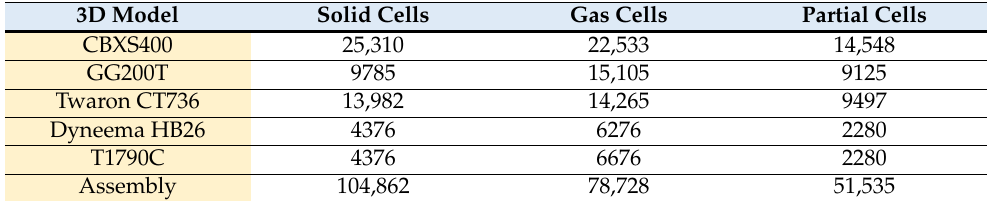
Table 3. Number of cells in 3D models of tested textile models.